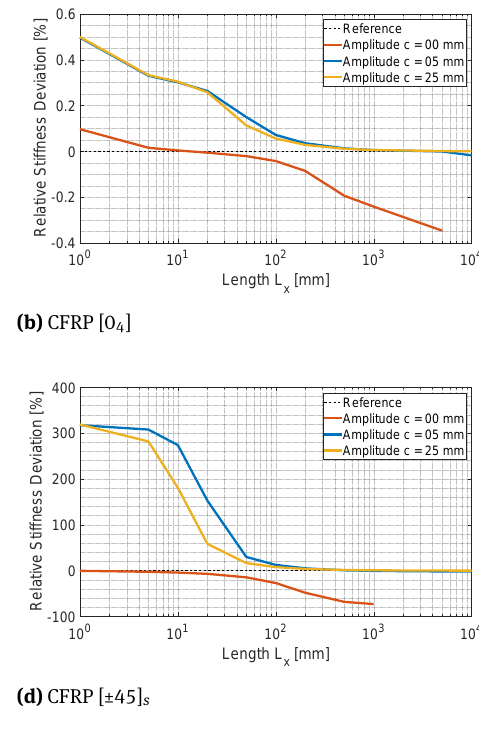
Figure 18: Load case 4 normalized apparent stiffnesses versus L